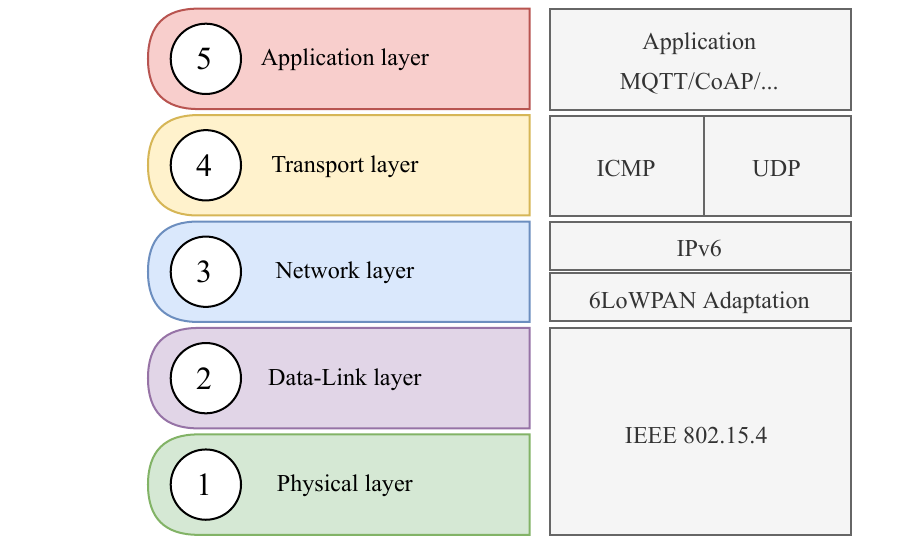
Figure 10. Comparing 6LoWPAN stack with OSI